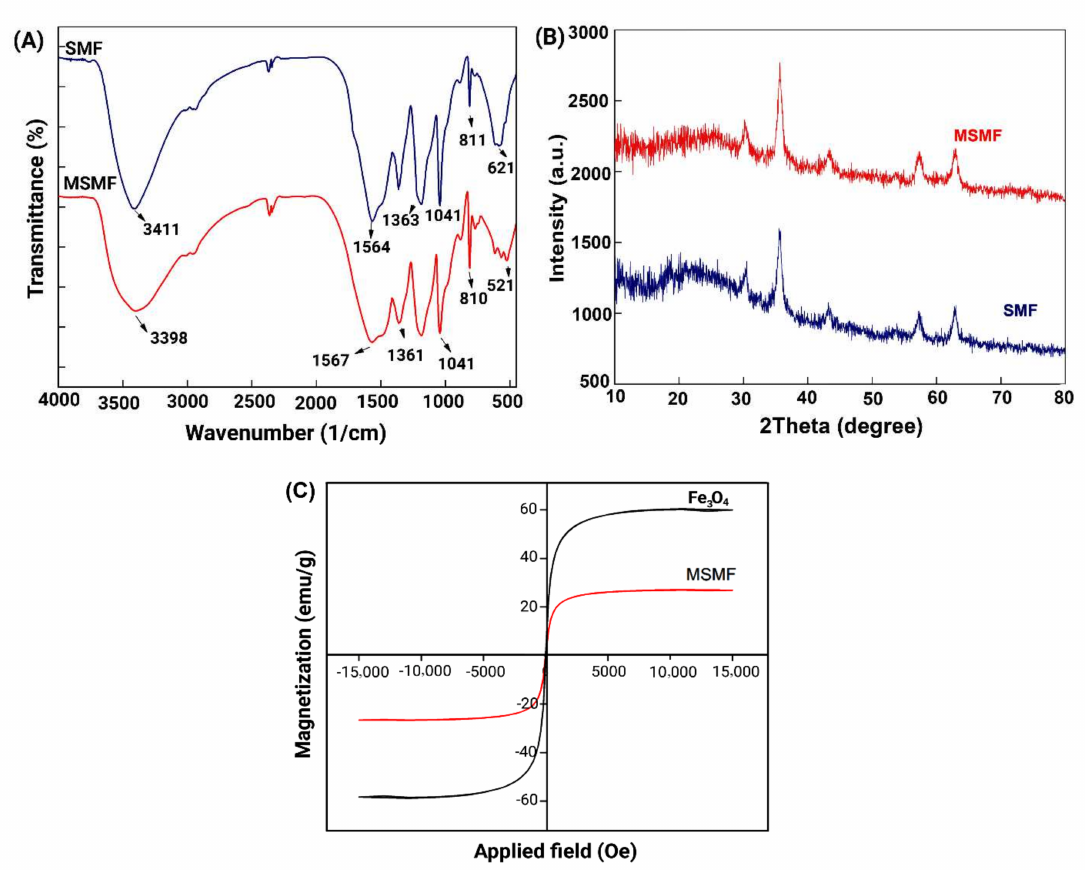
Figure 2. FTIR spectra ( A ) and XRD patterns ( B ) of SMF and MSMF. VSM curves of Fe 3 O 4 and MSMF ( C ). TG/DTG : The TG/DTG curves of SMF and MSMF are presented in Figure 3A,B.